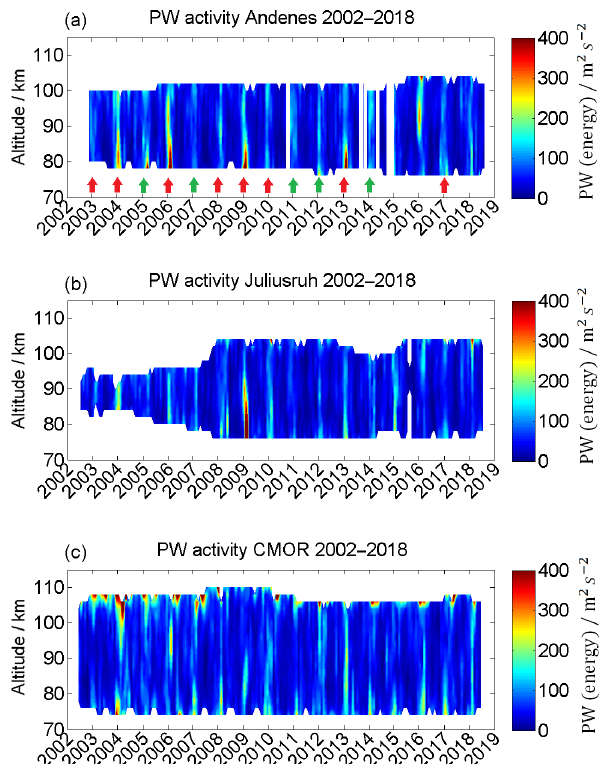
Figure 16. Time series of kinetic gravity wave energy for An- denes (a) , Juliusruh (b) , and CMOR (c)